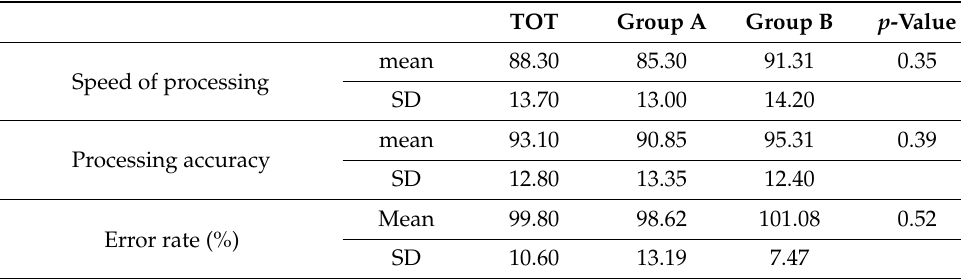
Table 3. Results of D2 test of attention in the patients of the